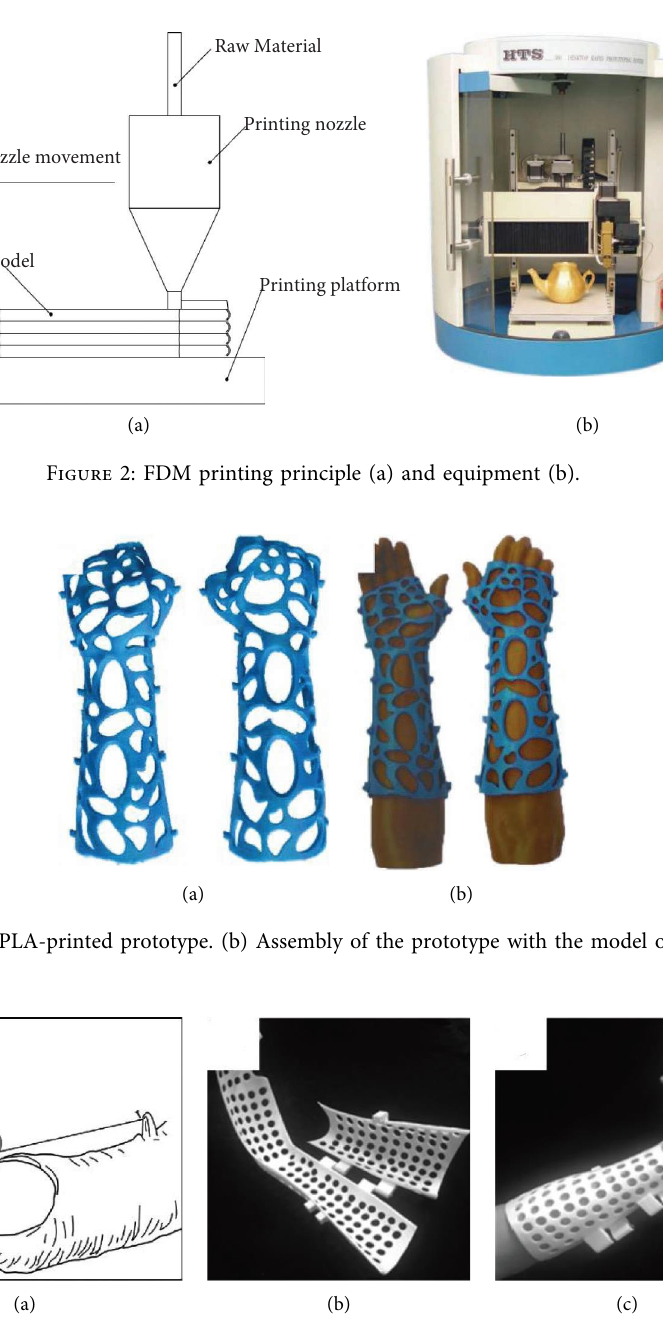
Figure 4: (a) Te traditional fxation method of fexor tendon injury. (b) and (c) are the 3D model of the brace.